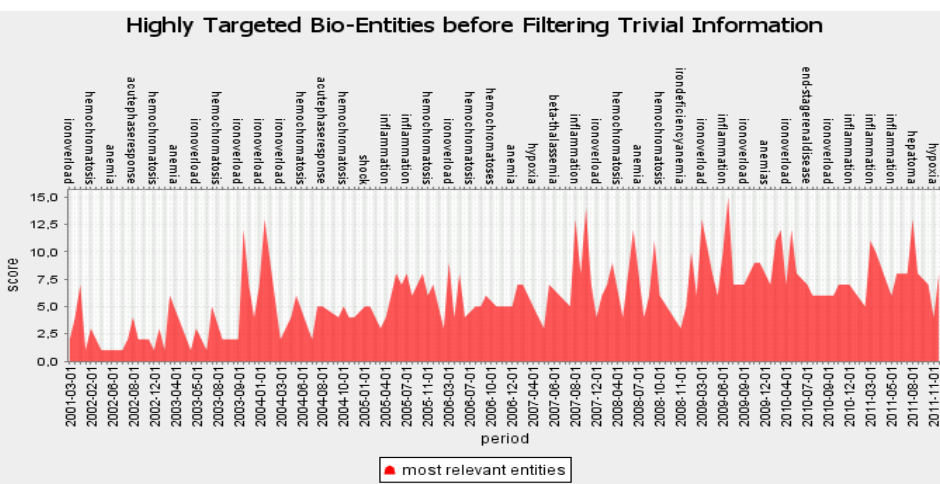
Figure 11. Highly targeted diseases when the background is